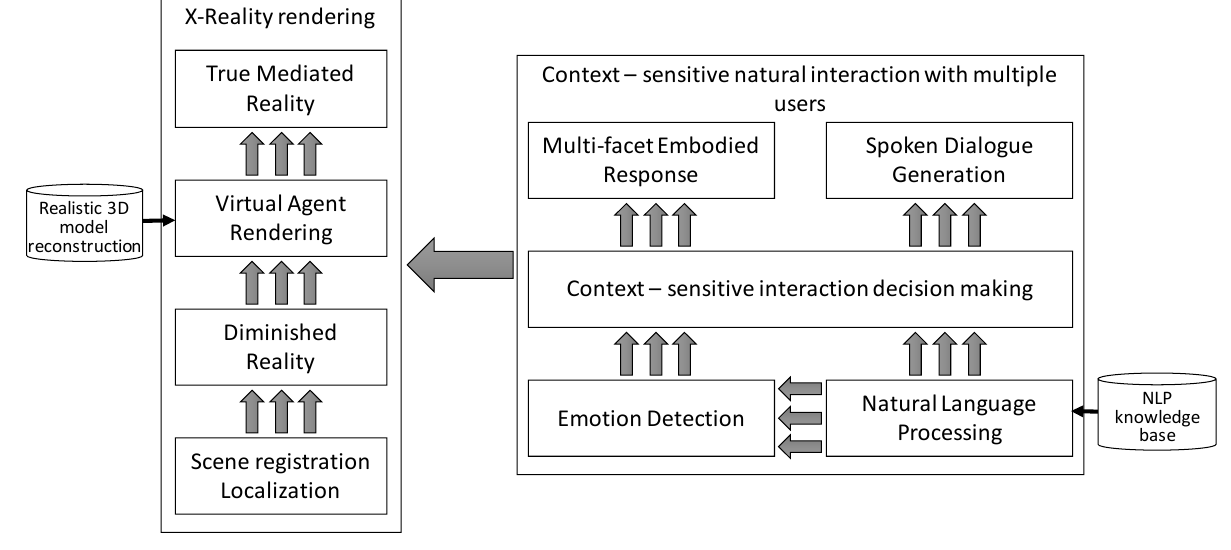
Figure 3. Conceptual architecture for realistic interaction with virtual statues in XR environments The orchestration of the above components towards delivering a realistic user experience, is exemplified through the imaginary scenario of a museum visitor interacting with a virtual Caryatid 5 statue, that